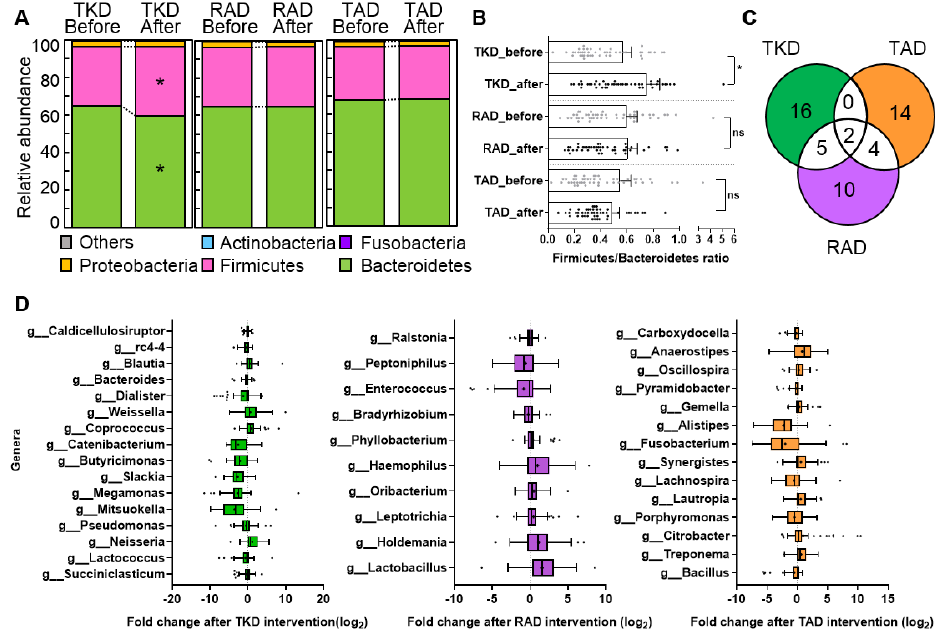
Figure 2. Di ff erential e ff ects of Korean diet and American diets on profiles of intestinal bacterial communities. ( A ) Relative proportions of gut microbial phyla before and after three diet intervention. ( B ) The ratio of Firmicutes to Bacteroidetes between before and after each diet intervention. ( C ) Venn diagram showing numbers of genera di ff erentially changed in response to TKD, RAD, and TKD intervention ( p < 0.05; Wilcoxon Signed-Rank test). ( D ) List of significant genera in comparison of before and after dietary intervention. Box plots of relative abundance show the fold change of after vs. before intervention in log 2 scale. Green, purple, and orange color indicates TKD, RAD, and TAD,